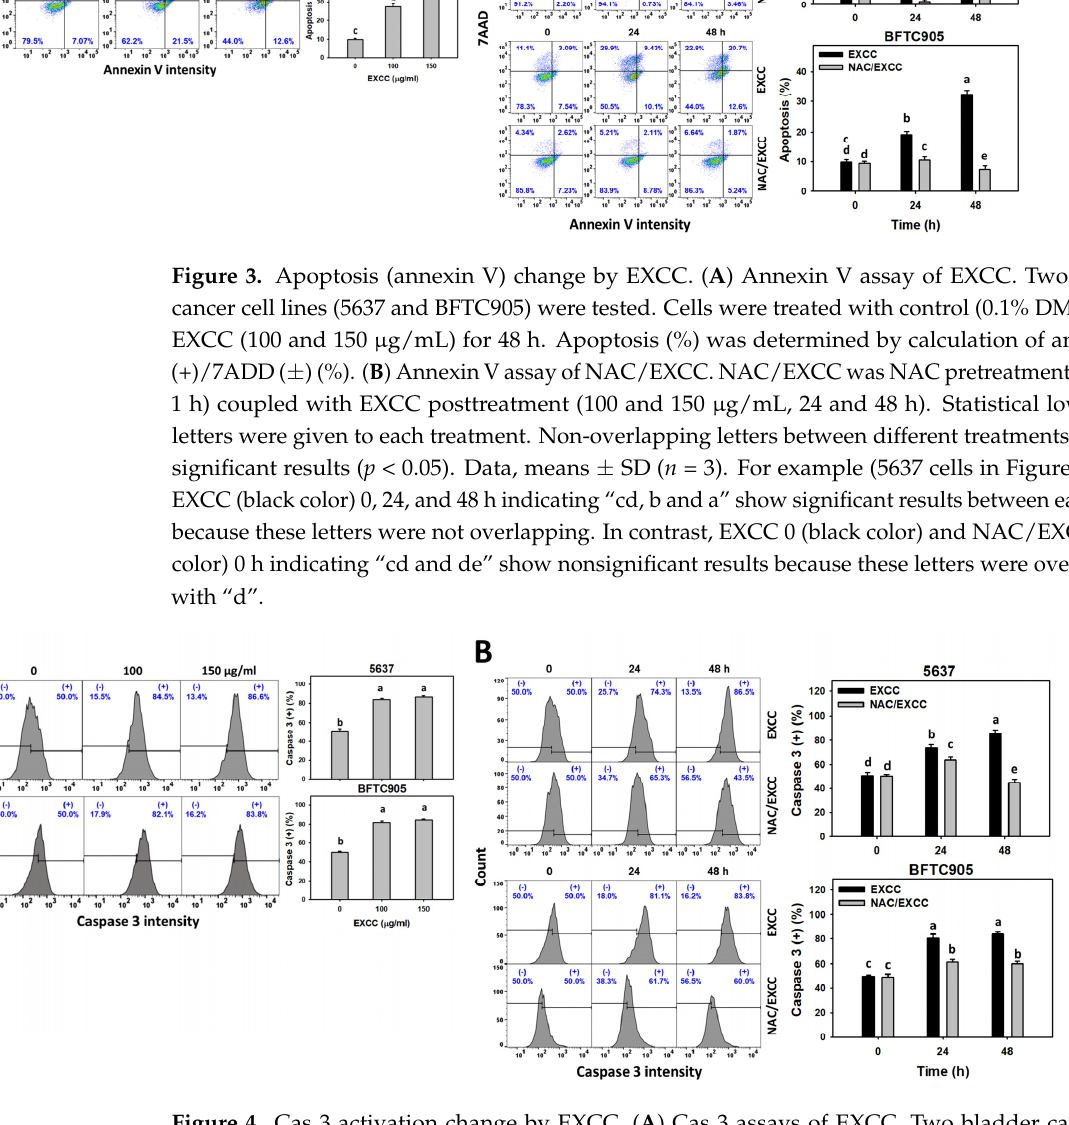
Figure 4. Cas 3 activation change by EXCC. ( A ) Cas 3 assays of EXCC. Two bladder cancer cell lines (5637 and BFTC905) were tested. Cells were treated with control (0.1% DMSO) and EXCC (100 and 150 µ g/mL) for 48 h. (+) represents the Cas 3 (+) population. ( B ) Cas 3 assays of NAC/EXCC. NAC/EXCC is the NAC pretreatment (10 mM, 1 h) coupled with EXCC posttreatment (150 µ g/mL, 24 and 48 h). Statistical lower-case letters were given to each treatment. Non-overlapping letters between different treatments indicate significant results ( p < 0.05). Data, means ± SD ( n = 3). For example (5637 cells in Figure 4B), the EXCC (black color) 0, 24, and 48 h indicating “d, b, and a” show significant results between each other because these letters were non-overlapping. In contrast, EXCC 0 (black color) and NAC/EXCC (gray color) 0 h indicating “d” show nonsignificant results because these letters